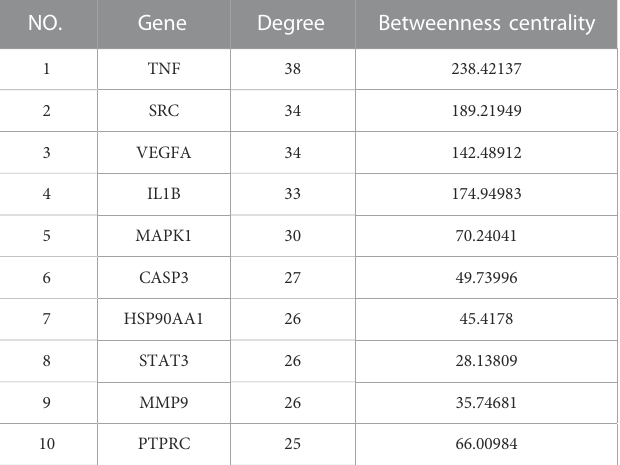
TABLE 2 Designations and topological parameters of hub components in the PPI